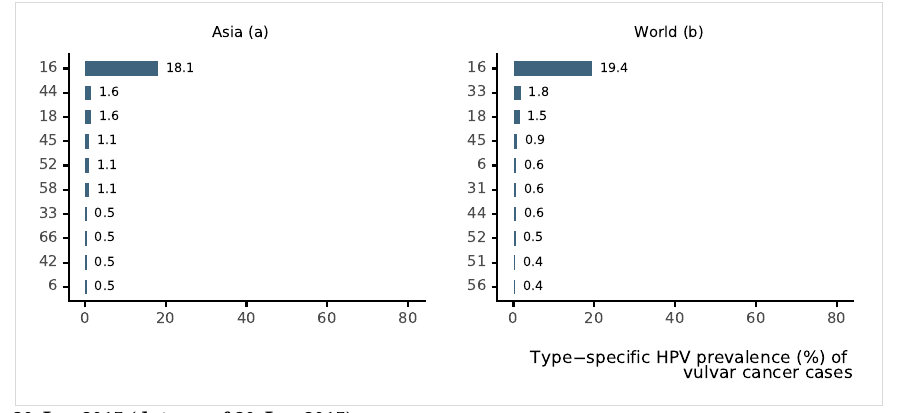
Figure 64: Comparison of the ten most frequent HPV types in cases of vulvar cancer in Asia and the World